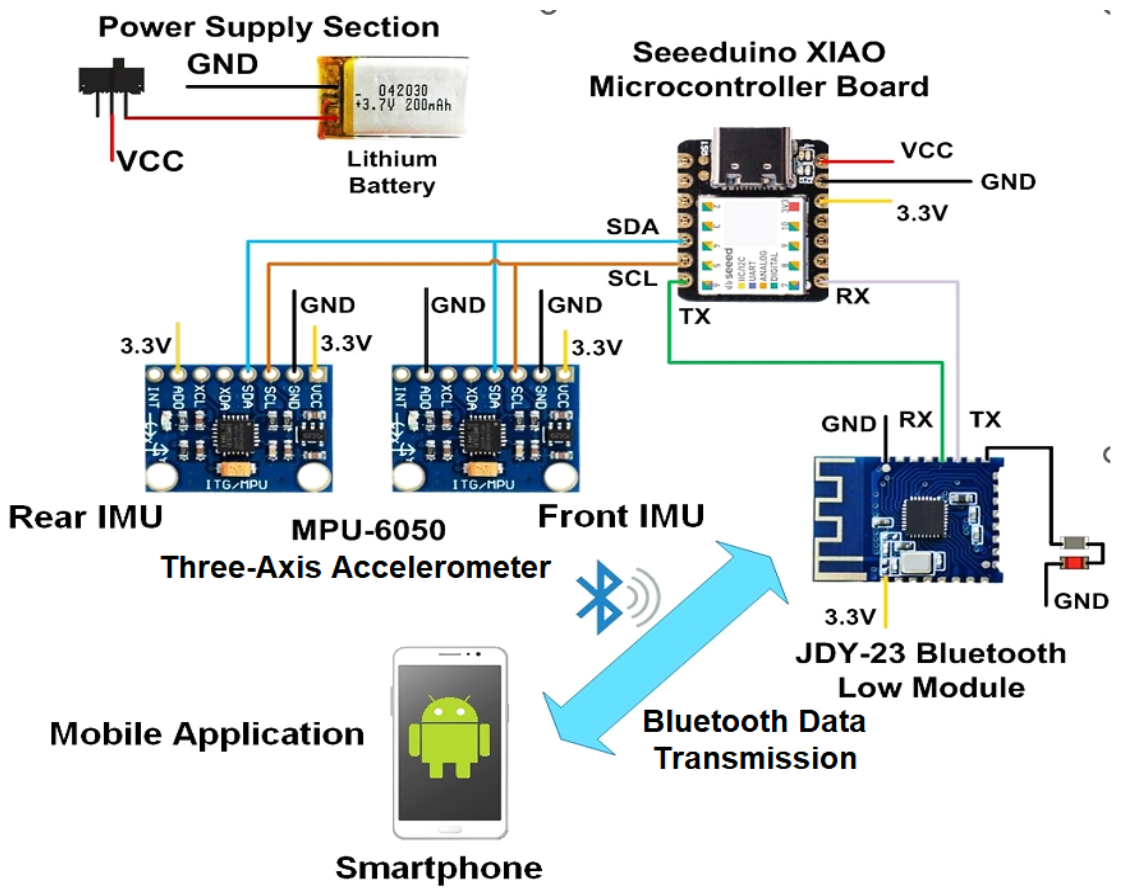
Figure 2. Architecture of the developed inertial-based chest band; the breathing parameters acquired by the chest band are sent through Bluetooth transmission to a mobile application to be viewed.